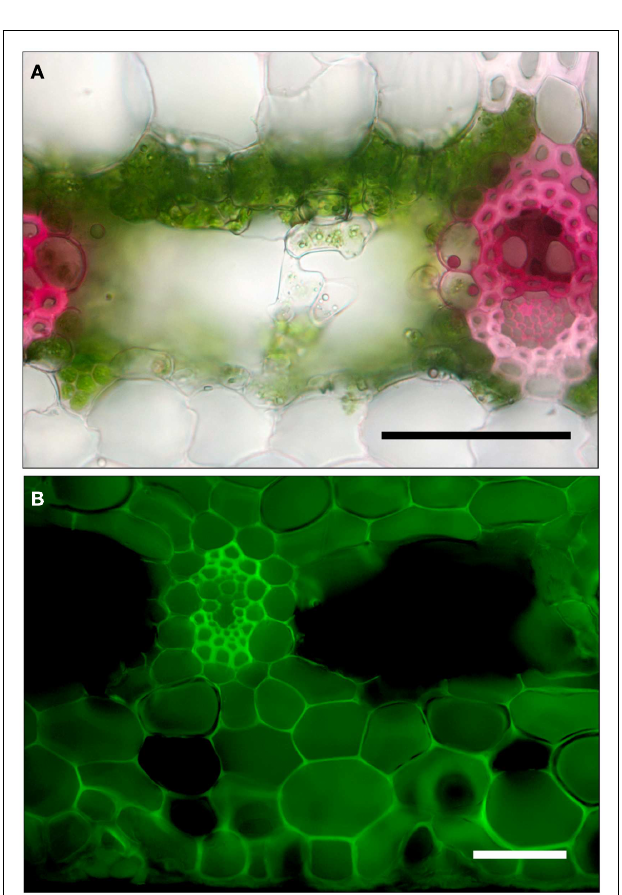
FIGURE 3 | Cross-sections of leaves of G. lingulata . (A) Leaf blade after cut end was immersed in 0.1% basic fuchsin dye for 1h. (B) Tank region, after leaf was cut, sealed at the cut end, and immersed in 0.1% sulforhodamine G for 1h; scale bars in (A) and (B) = 50 µ